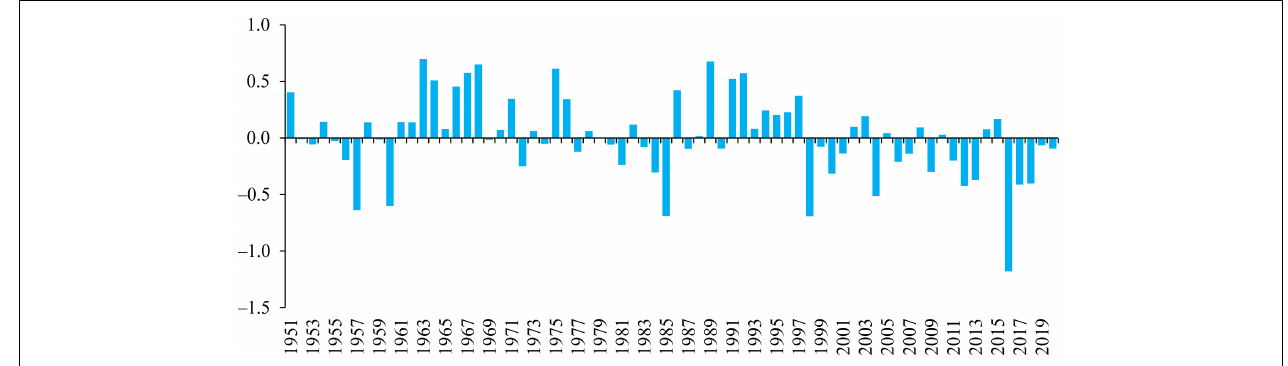
FIGURE 6 | Averaged annual values of the Polar/Eurasian Index from 1951 to 2020 (calculated according to NOAA data,